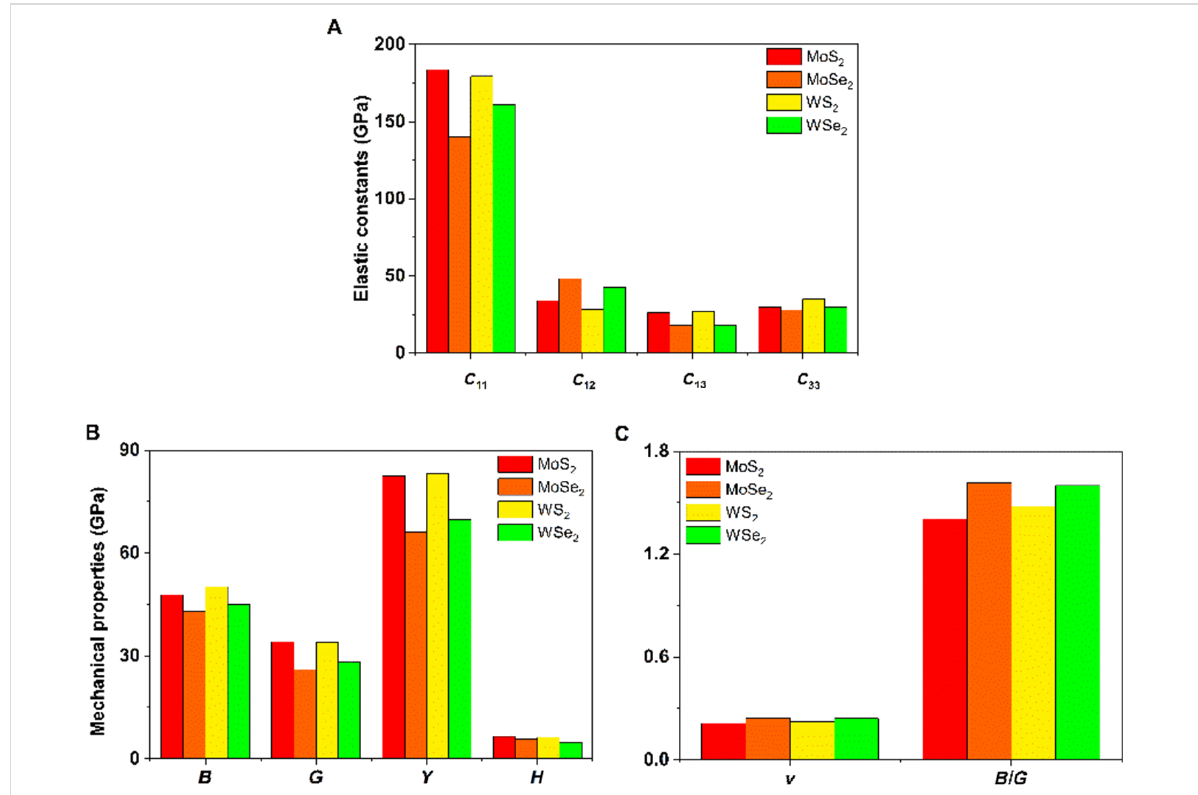
Figure 4: Calculated mechanical properties of 1T ′ MoS 2 , MoSe 2 , WS 2 and WSe 2 crystals including (A) the elastic constants, (B) bulk moduli ( B ), shear moduli ( G ), Young’s moduli ( Y ), microhardness ( H ), and (C) Poisson’s ratio ( ν ) and B / G ratios.